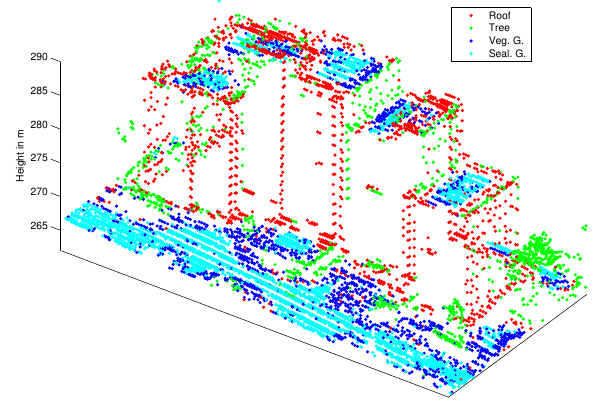
Figure 7: High-rise buildings. Without the use of further features, flat roofs are mistaken as